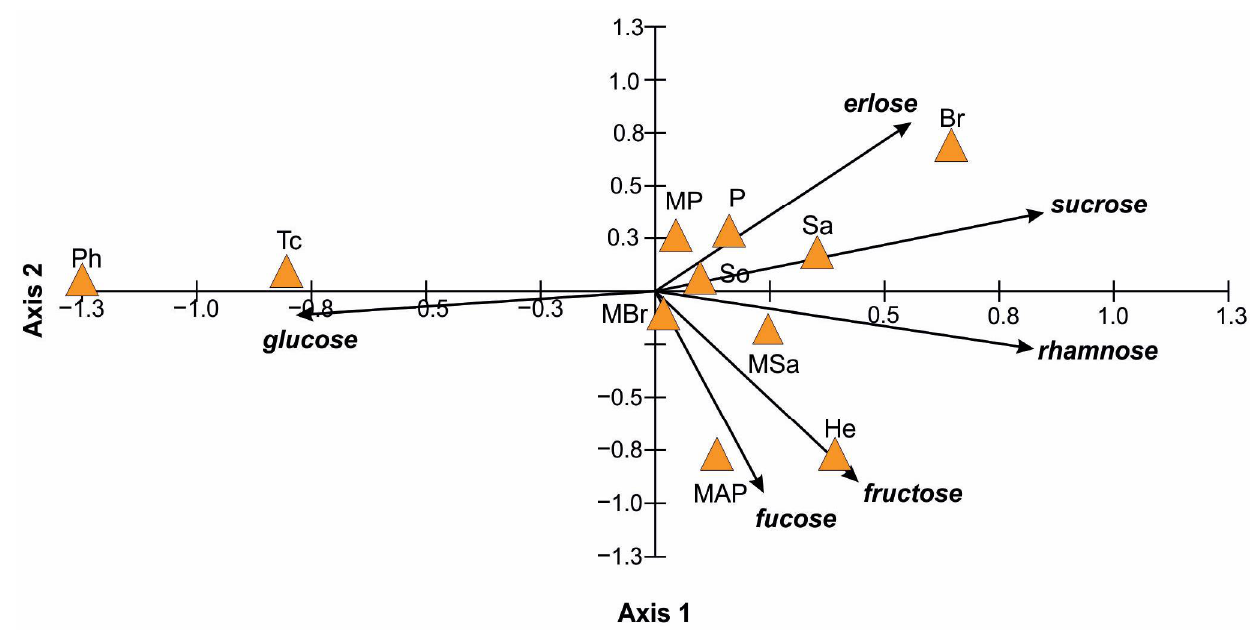
Figure 2. Principal component analysis (PCA) ordination diagram illustrating differences in sugar content among the 11 study honeys (solid line vectors). Content of sucrose determined the positive gradient and glucose content negative gradient of axis 1. In the case of axis 2, the positive gradient was determined by the erlose content and negative by fructose.